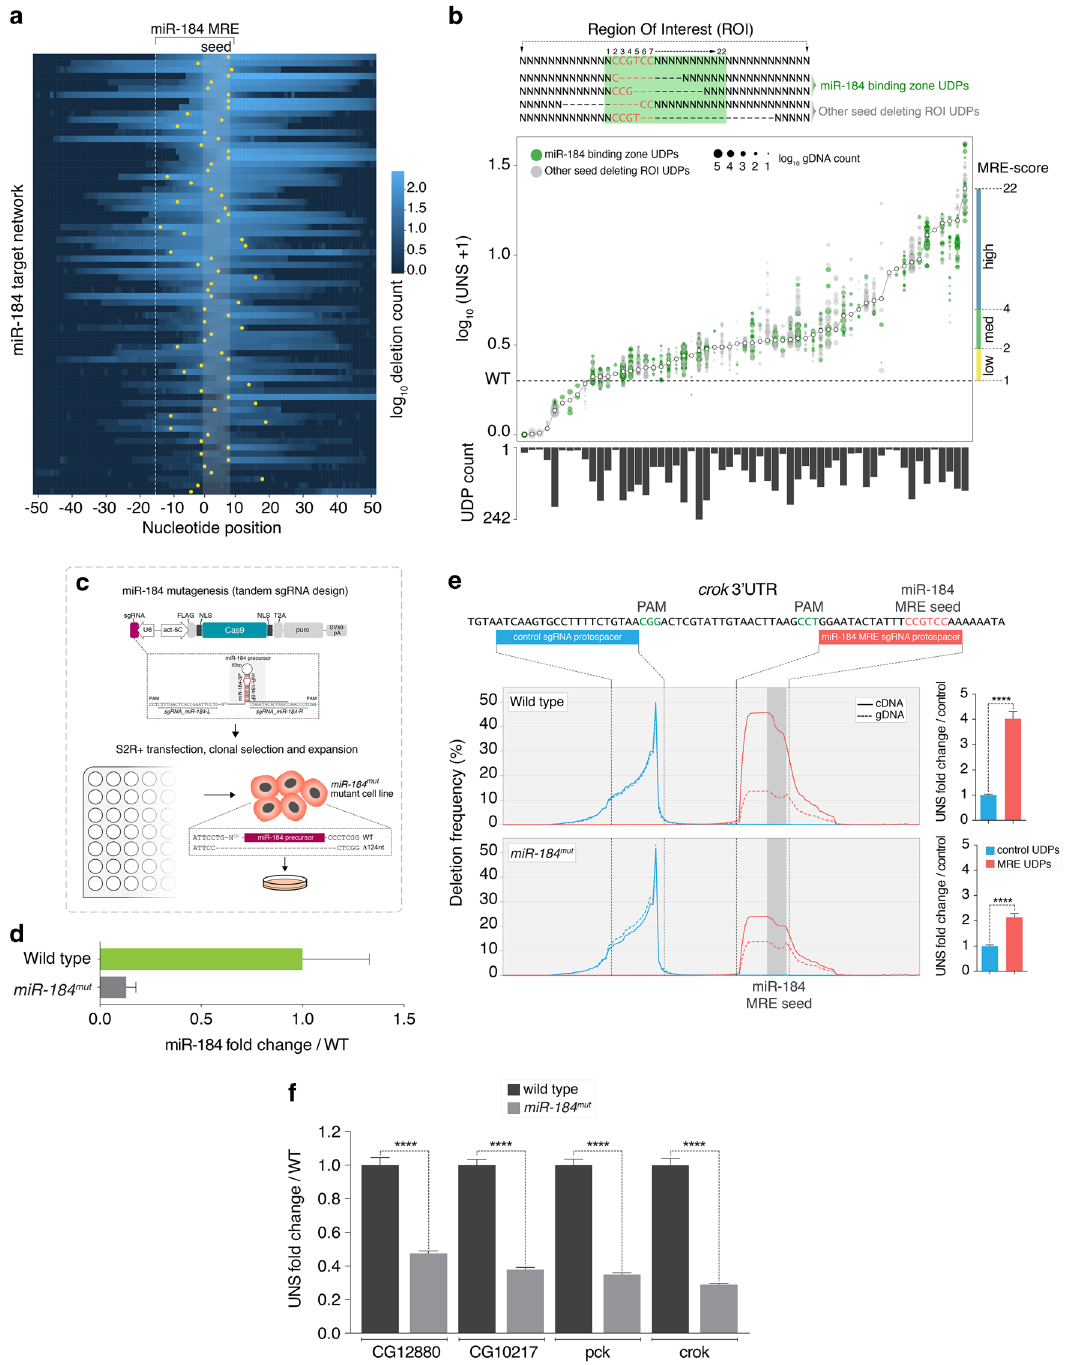
Fig. 6 GenERA-based analysis of a predicted MRE network activity. a UDP repertoire ( blue gradient = number of UDPs overlapping a given nucleotide) across the miR-184 target network. Boundaries of the predicted miR-184 binding zone ( dashed line ), extended seed region ( shaded area), and Cas9 DNA double stranded break sites ( yellow dots ) are highlighted. b Spatial distribution of seed-deleting UDPs selected for MRE-score calculation ( top ). UDPs restricted to the miRNA binding zone ( green nt. 1 – 22) and extending to the full ROI ( gray ) were considered in the analysis. Ranked MRE-score distribution across the miR-184 MRE network ( white dots ) ( bottom ). Underlying UNS values ( fi rst to last quartiles) are shown with their sequencing depth (dot size) and spatial distribution ( green and gray ). Bar plot re fl ects total UDP counts contributing to each MRE-score calculation. Right y axis shows partitions in high , medium , and low MRE-score groups based on the empirical distribution of the data. c Generation of miR-184 mut cell line by CRISPR-Cas9 genome editing. d Quanti fi cation of mature miR-184 levels by RT-qPCR in wild type cells and miR-184 mut cells ( n = 3 for each group , error bar = SEM). e Validation of GenERA data. Analysis of crok cDNA and gDNA deletion frequency pro fi les in wild type and miR-184 mut cells at a control locus ( blue ) compared to the predicted miR-184 MRE locus ( red ) (left plots). Quanti fi cation of UNS fold change from MRE UDPs normalized to control UDPs in wild type and miR-184 mut cells ( right bar graphs, Error bar = SEM, Mann-Whitney test, ****P < 0.0001). f Comparative GenERA analysis of four top-ranking miR-184 MREs reveals a signi fi cant fold change difference between wild type and miR-184 mut cells, demonstrating dependence of the observed effects on miR-184 mediated regulation ( Error bar = SEM, Mann-Whitney test, ****P < 0.0001) NATURE COMMUNICATIONS | 8: 2109 | DOI: 10.1038/s41467-017-00686-2 | www.nature.com/naturecommunications